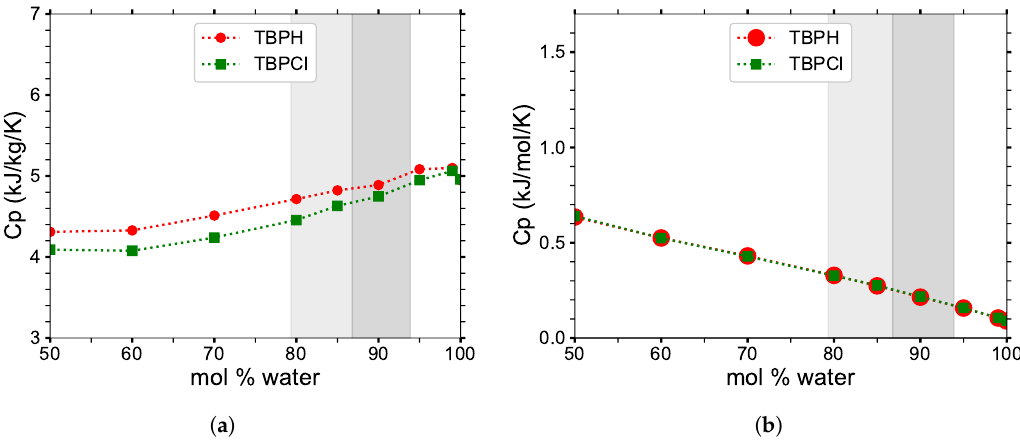
Figure 14. Heat capacity ( c p ) of TBPH–water and TBPCl–water mixtures at p = 1atm and T = 300K on a ( a ) per gram basis and ( b ) per mole basis, in which the values are overlapping.